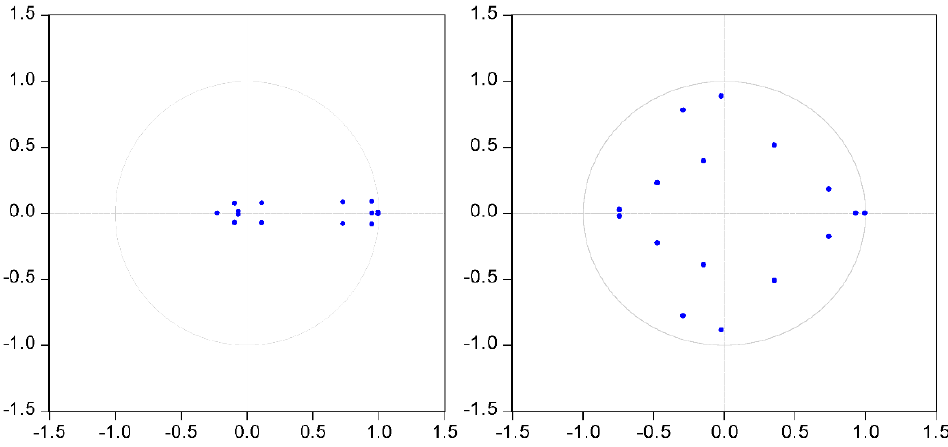
Figure 1. Inverse root of AR characteristics polynomial.